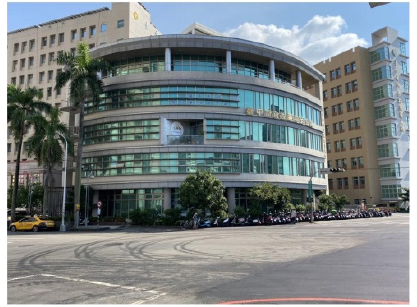
Figure 2. The test site of office building in urban area.